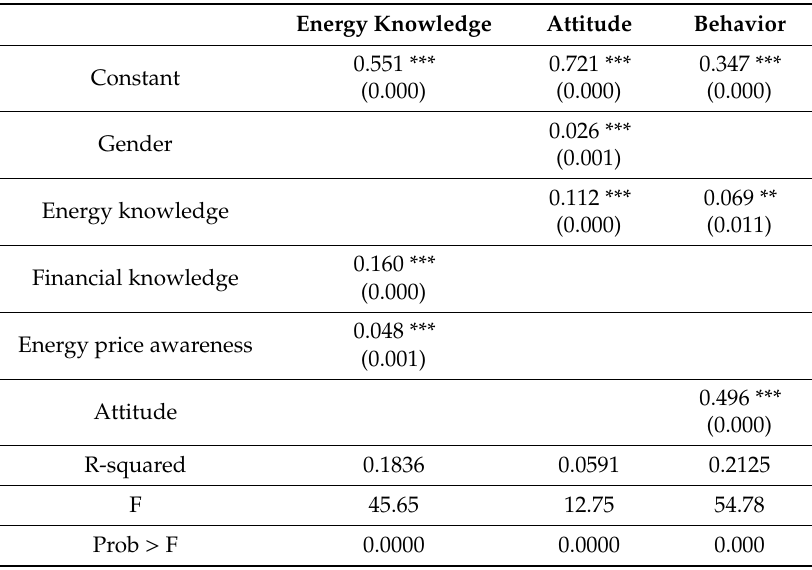
Table 4. Best models according to stepwise